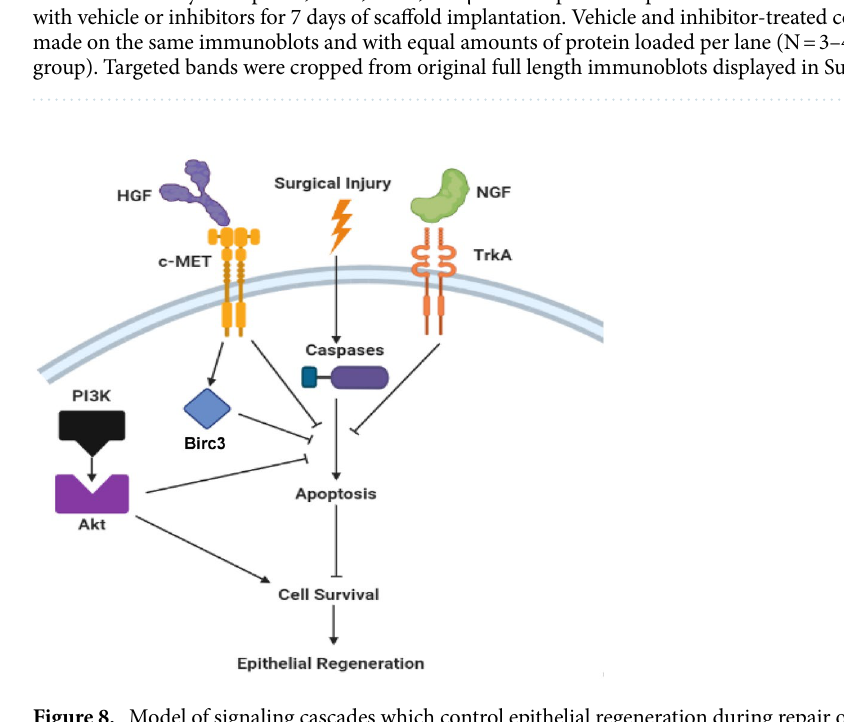
Figure 8. Model of signaling cascades which control epithelial regeneration during repair of surgical esophageal defects. Following surgical integration of acellular grafts, c-MET and TrkA receptors are activated in host epithelial cells buttressing the defect site via respective binding of HGF and NGF ligands. These pathways lead to inhibition of pan-caspase activity in the neoepithelium which mitigates apoptosis and encourages epithelial survival allowing for epithelial regeneration to occur. In addition, c-MET activation leads to upregulation of the anti-apoptotic protein, Birc3. In parallel, surgical injury also activates PI3K which leads